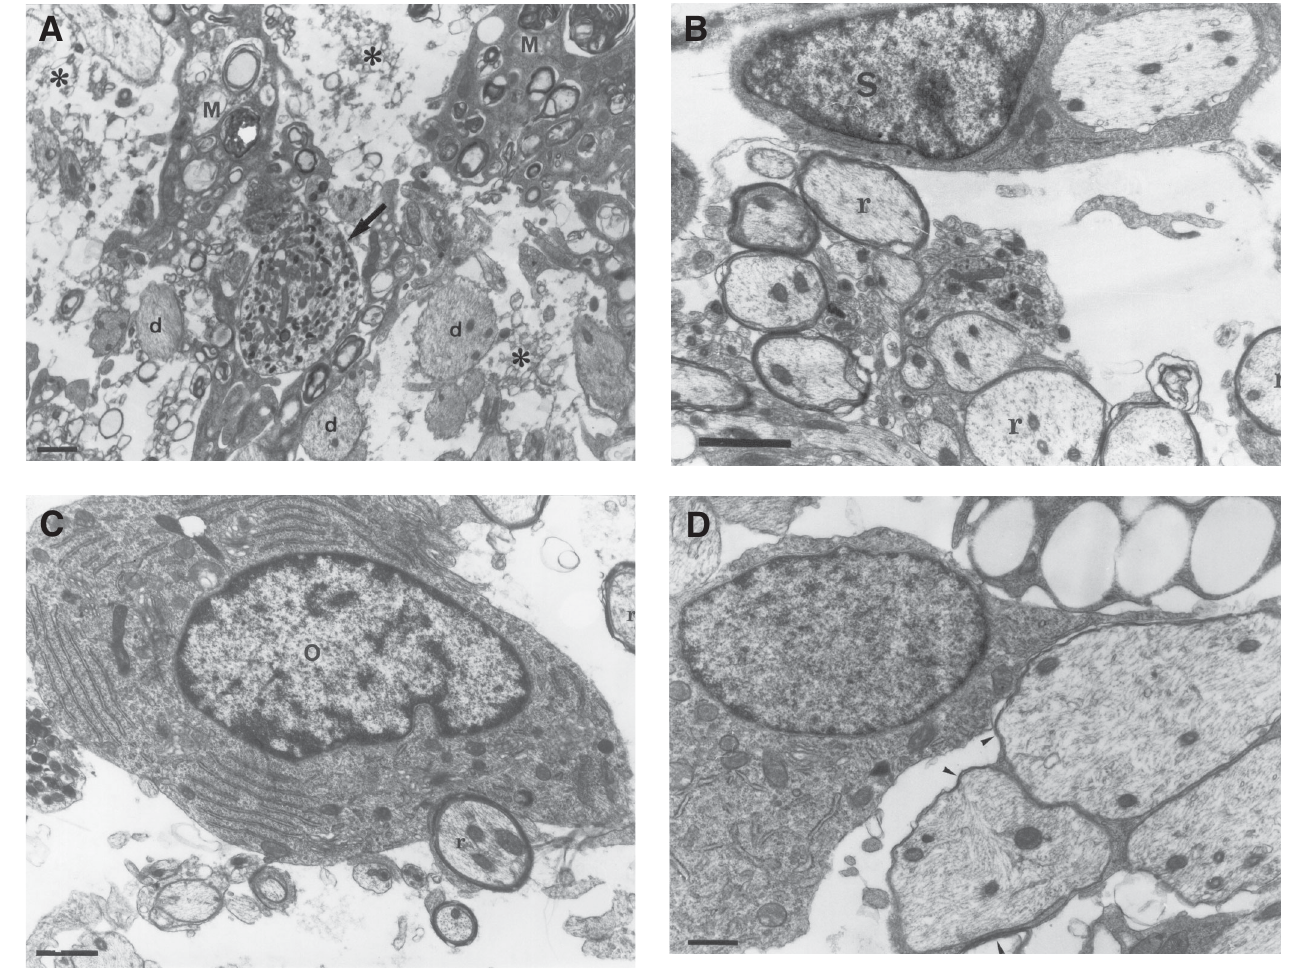
Figure 2. Group I. A , 7 days after ethidium bromide injection. Demyelinated axons (d) in an area containing large amounts of myelin-derived membranes (asterisks), phagocytic cells (M) and even a degenerating axon (arrow). Bar = 1 µm. B , 15 days after ethidium bromide injection. A Schwann cell (S) surrounds a naked axon near some oligodendrocyte-remyelinated axons (r). Bar = 5 µm. C , 15 days after ethidium bromide injection. An oligodendrocyte (O) is seen next to thinly remyelinated axons (r). Bar = 1 µm. D , 21 days after ethidium bromide injection. Axons present initial deposition of few myelin lamellae (arrowheads) of oligodendroglial origin. Bar = 0.5